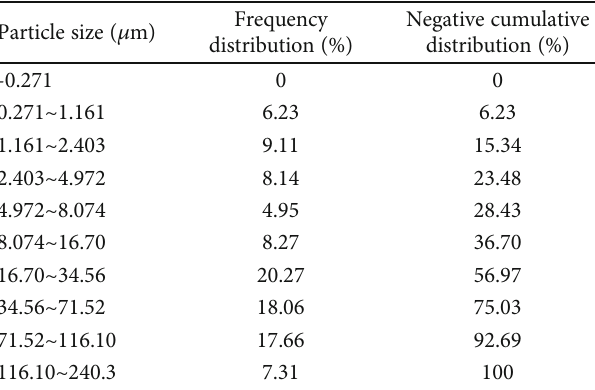
Figure 1: Size distribution curve of total Table 2: Test results of particle size distribution of total tailings.